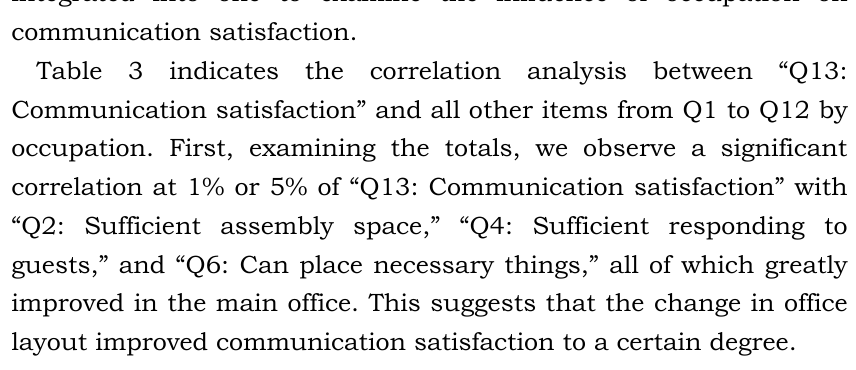
3 indicates the correlation analysis between